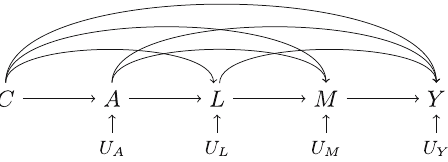
Figure 2: A shorthand DAG: C is a collection of variables, each of which has at least two of the four depicted arrows emitted from C